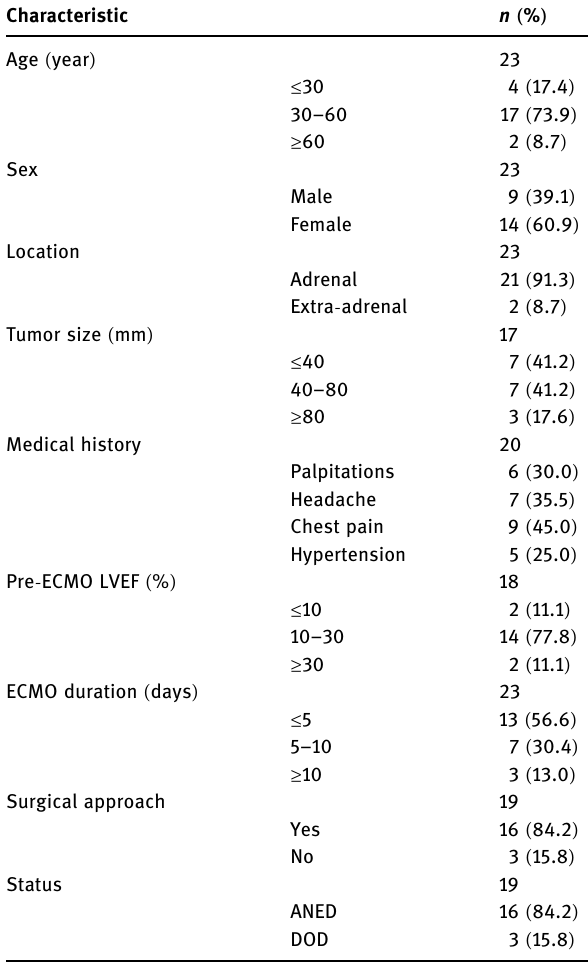
Table 1: Summary of the reported clinical characteristics of ECMO for the treatment of cardiogenic shock due to paraganglioma - or pheochromocytoma - induced cardiogenic shock